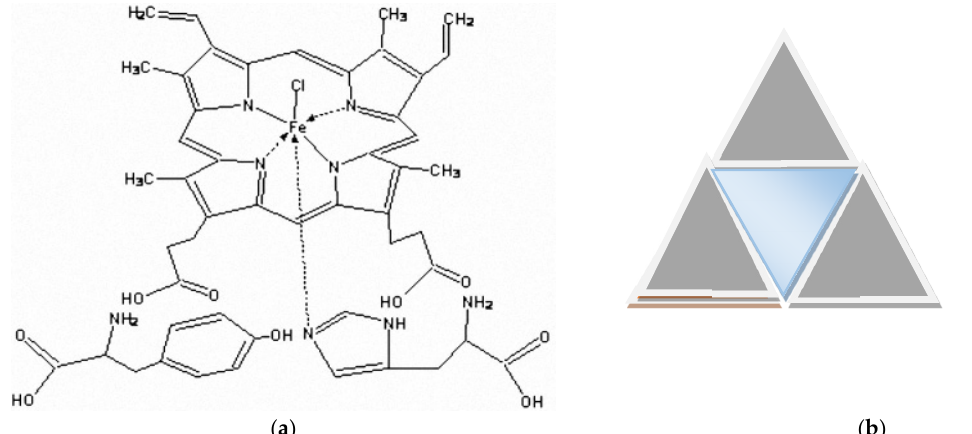
Figure 7. The possible triangular structure of {Hem•Tyr•His} complex that is formed due to H-bonds NH•••O or N•••HO ( a ). The combination of individual triangles into structures such as Sierpinski triangular motifs ( b ).